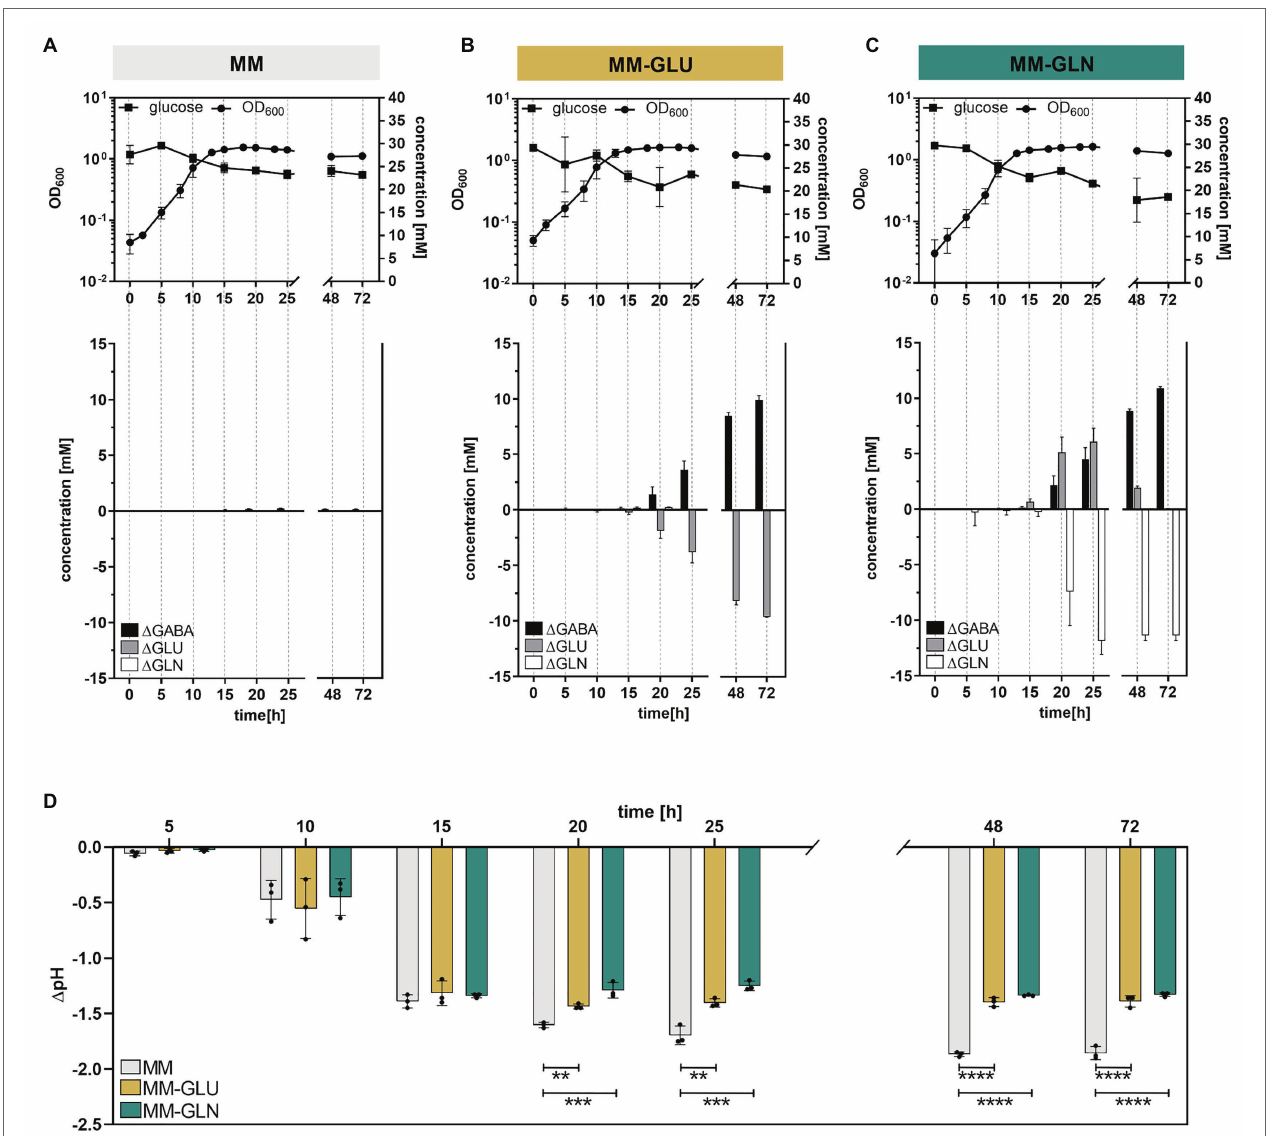
FIGURE 4 | GABA production kinetic in the presence or absence of glutamine and glutamate in minimal medium (MM). Growth curves (log-scale) of Bacteroides thetaiotaomicron DSM 2079 cultivated in (A) MM, (B) MM-Glu, and (C) MM-Gln ( n = 3). Changes in glucose, GABA, glutamine, and glutamate concentrations for 72 h are displayed. (D) Change in pH associated with B. thetaiotaomicron DSM 2079 growth for 72 h in MM, MM-Glu, and MM-Gln. Dots represent replicates; bars represent SD. Significances were calculated by one-way ANOVA test, including Tukey’s test: ** p < 0.01; *** p < 0.001; **** p < 0.0001. Data on metabolic acid production and absolute pH are available in Supplementary Figure S6